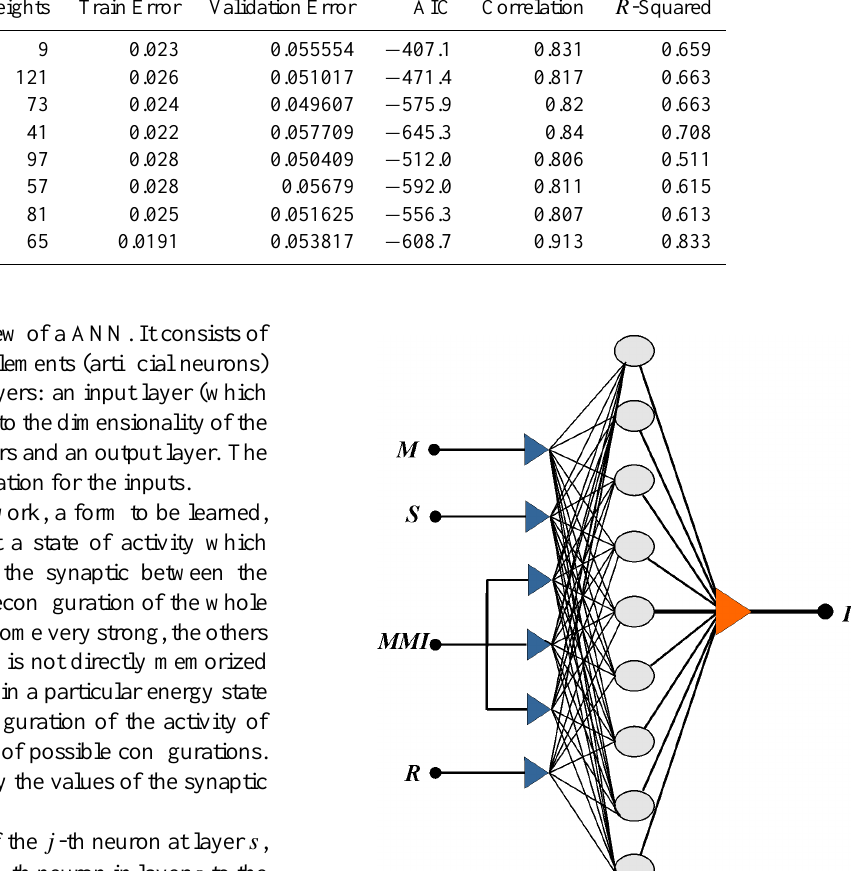
Table 2. Network performance for a different number of neurons in the hidden layer. AIC refers to the Akaike’s Information Criterion defined by AIC = T ln(RSS) + 2 k , where k is the number of regressors, T the number of observations and RSS the residual sum of square. ANN Weights Train Error